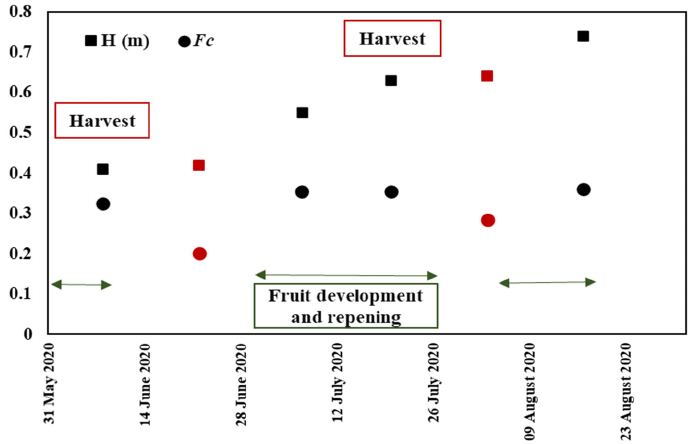
Figure 6. The temporal evolution of pepper biophysical parameters: Vegetation cover fraction ( Fc ) and vegetation height (H) during the pepper growth cycle where red arrows indicate fruit harvest events.